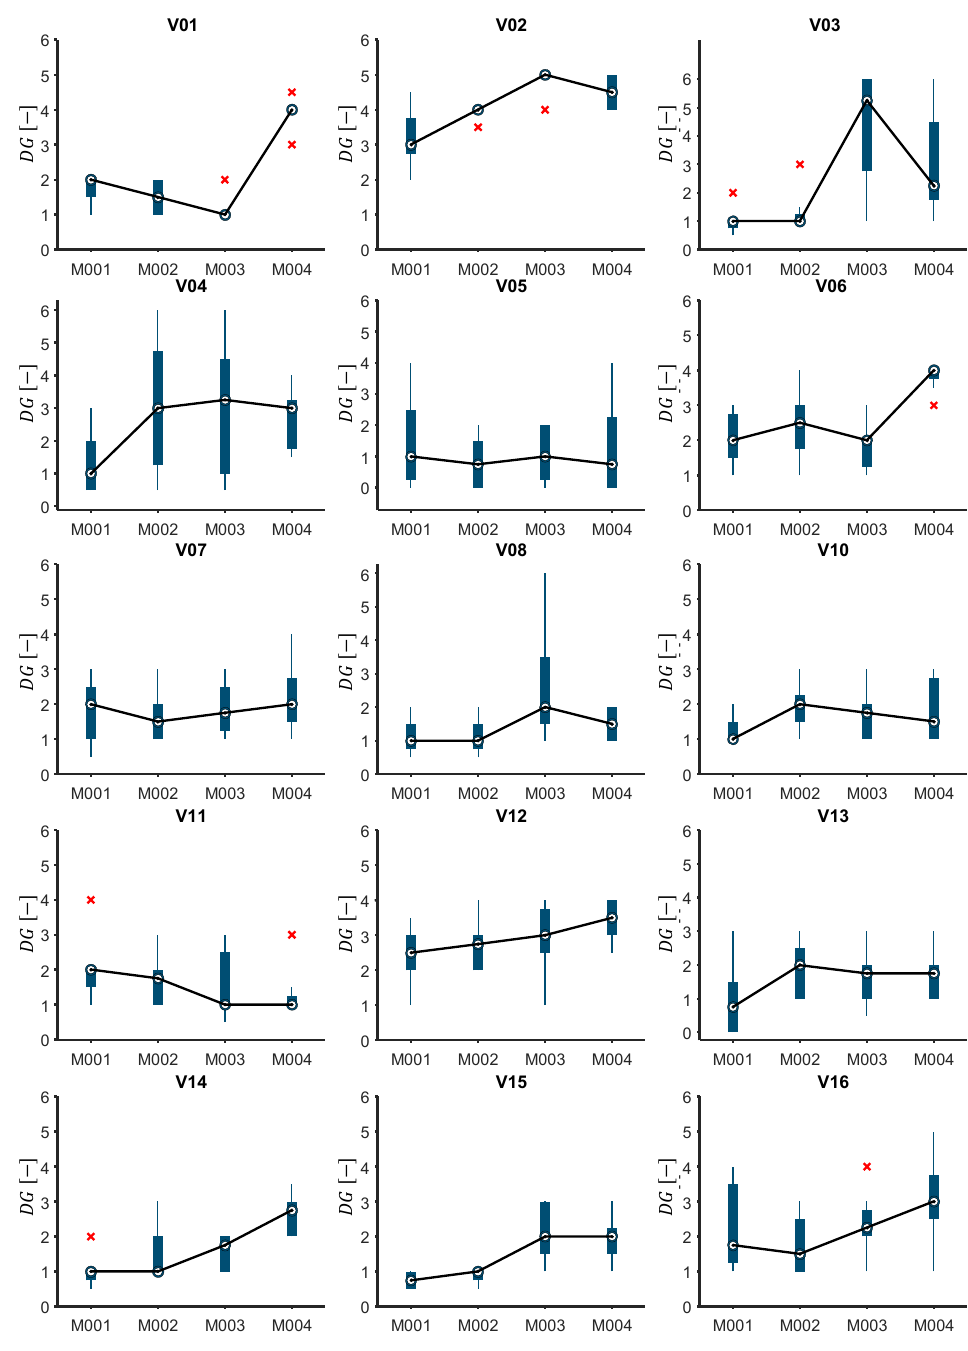
Figure A1. Assessed damage grade ( DG ) of tests V01–V16 of a 51305 axial ball bearing after 3 h (M001), 6 h (M002), 9 h (M003) and 21 h (M004) of electric damaging. Circles mark the median, boxes mark the interquartile range, vertical lines mark the overall range of values and crosses mark outliers.